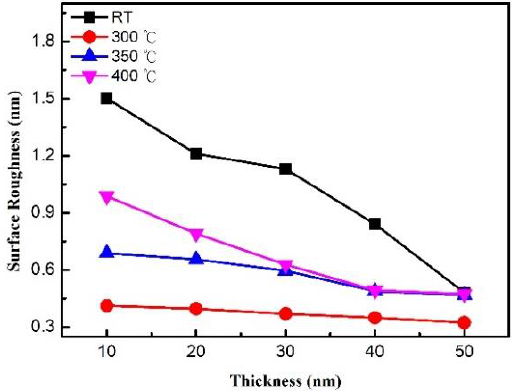
Figure 5. Surface roughness of various CoFeW thin films.